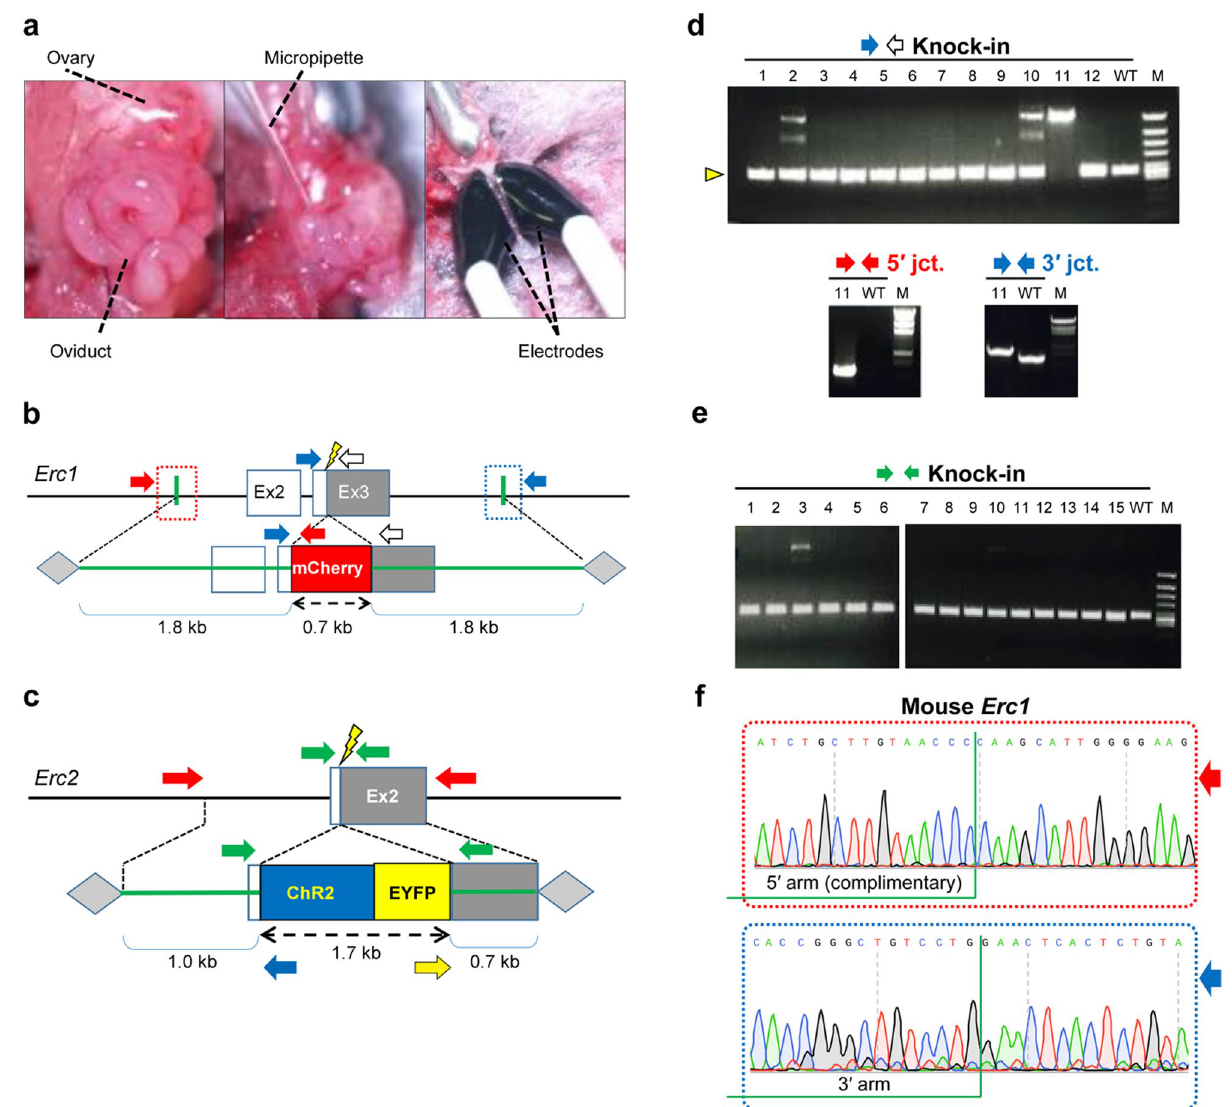
Figure 2. Generation of knock-in mice by in situ electroporation using AAV1 donors. ( a ) Procedure of in situ electroporation. Our protocol is based on the i -GONAD method, which has been well described in other reports 17, 44 . Left: exposed ovary and oviduct are shown; middle, CRISPR components are instilled into the oviduct lumen using a glass micropipette; right, the entire oviduct covered with a small wet paper is electroporated using tweezer-type electrodes. ( b , c ) Schematic of strategy to insert a mCherry fluorescent reporter or ChR2-EYFP cassette into endogenous Erc1 (ELKS) or Erc2 (CAST) locus, respectively. Arrows indicate the PCR primers. ( d , e ) Confirmation of insertions by genomic PCR. Two Erc1 knock-in heterozygous (No. 2 and No. 10) and one homozygous (No.11) (in d ), and one Erc2 knock-in heterozygous (No. 3) (in e ) mice were obtained. Wild-type expected band size (yellow triangle): 0.3 kb; knock-in expected band size: 1.1 kb; 5 ′ expected band size: 2.1 kb; 3 ′ expected band size: 2.3 kb in d . Knock-in expected band size: 2.1 kb; wild-type expected band size (yellow triangle): 0.4 kb in e . M, ϕX174- Hinc II digested (in d , upper and in e ) or λ- Sty I digested (in d , lower) DNA marker; WT, wild-type mice. The cropped gel images were grouped from different parts of the same experimental result in e. (Supplementary Fig. S5,S6) ( f ) Representative sequencing chromatograms for correctly edited mCherry-ELKS knock-in